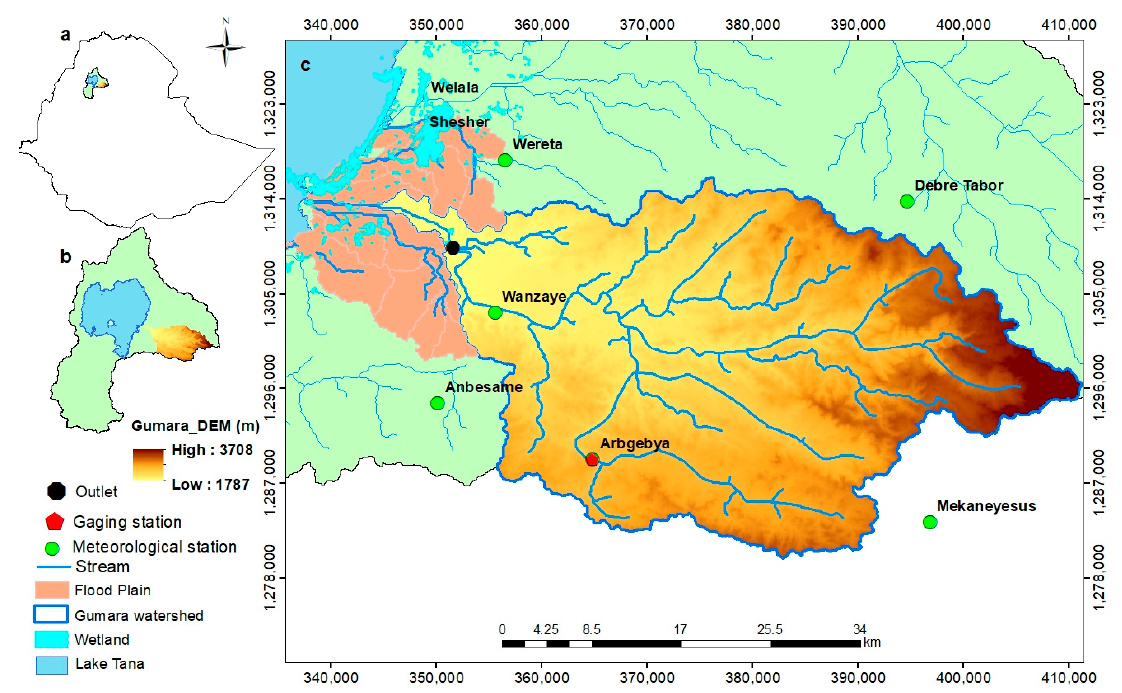
Figure 2. Location map of the study area; ( a ) Ethiopia, ( b ) Lake Tana Sub-basin and ( c ) elevation map of the Gumara watershed; the Gumara floodplain (orange) and Welala and Shesher wetlands (blue) are shown. The boundaries of the Gumara floodplain are approximate due to small elevation differences and depend on the height of the flood.